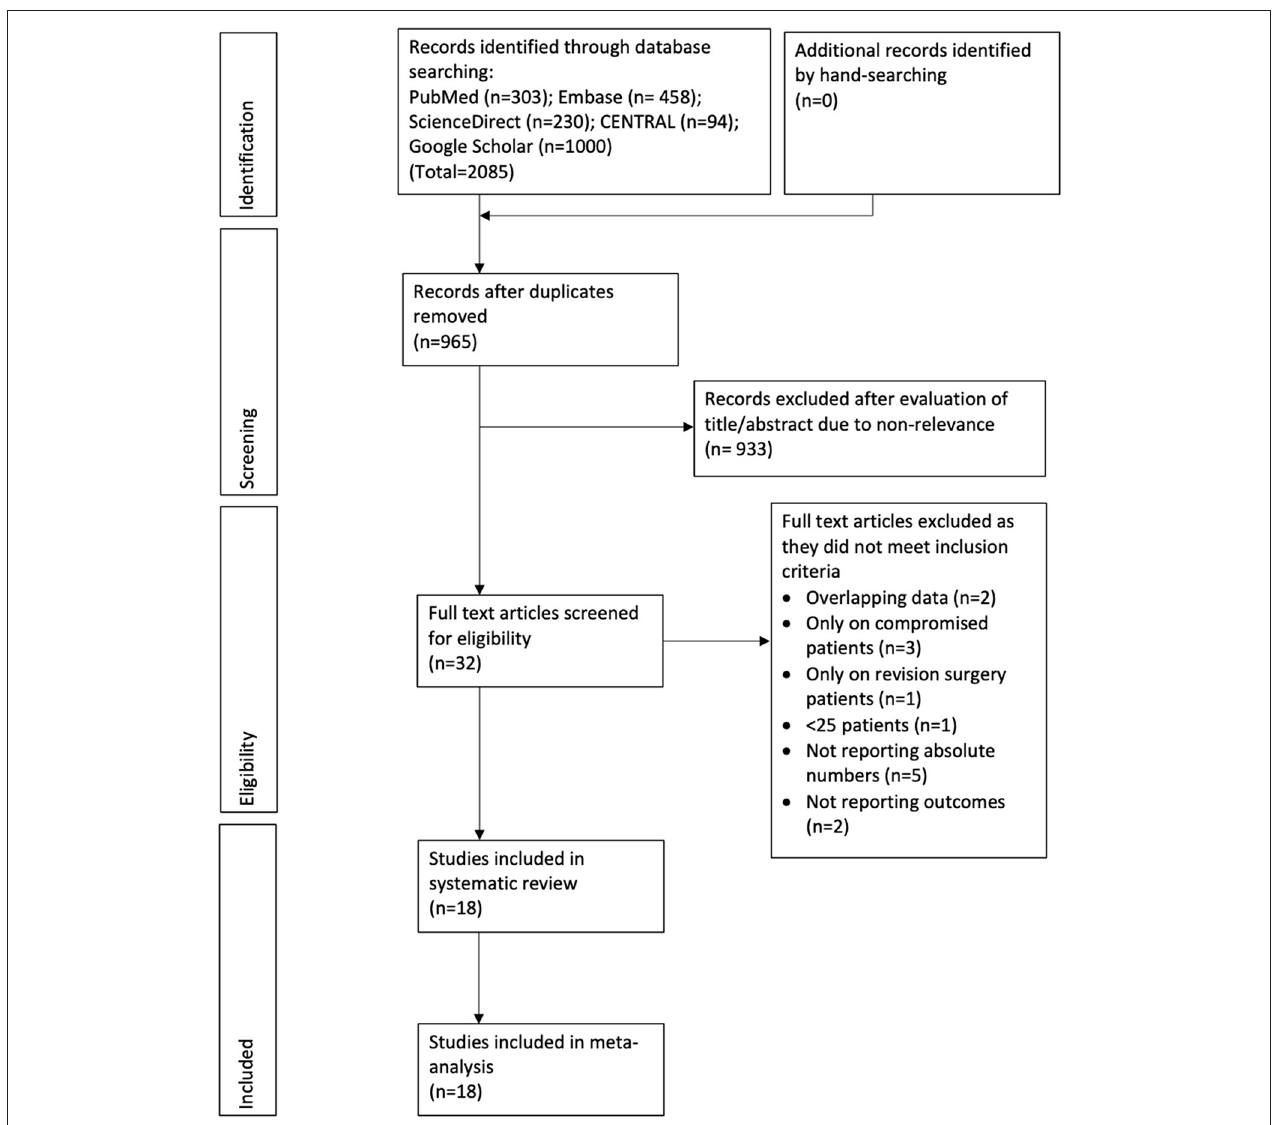
FIGURE 1 | Study flow